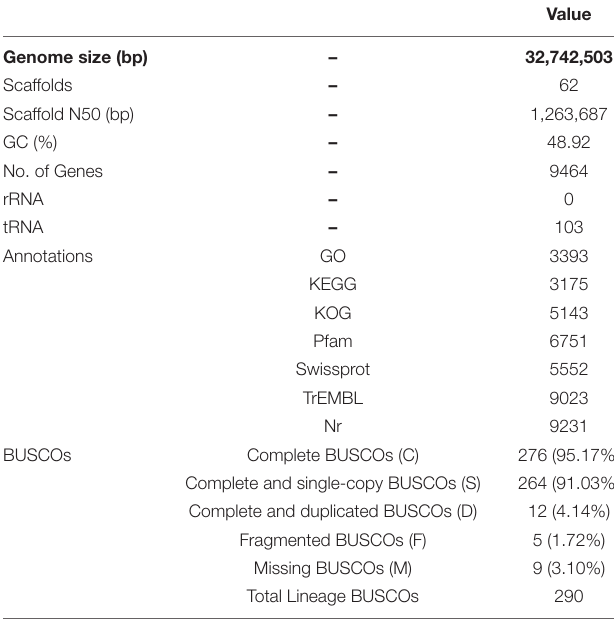
TABLE 1 | Statistical information associated with the genome sequenced in this